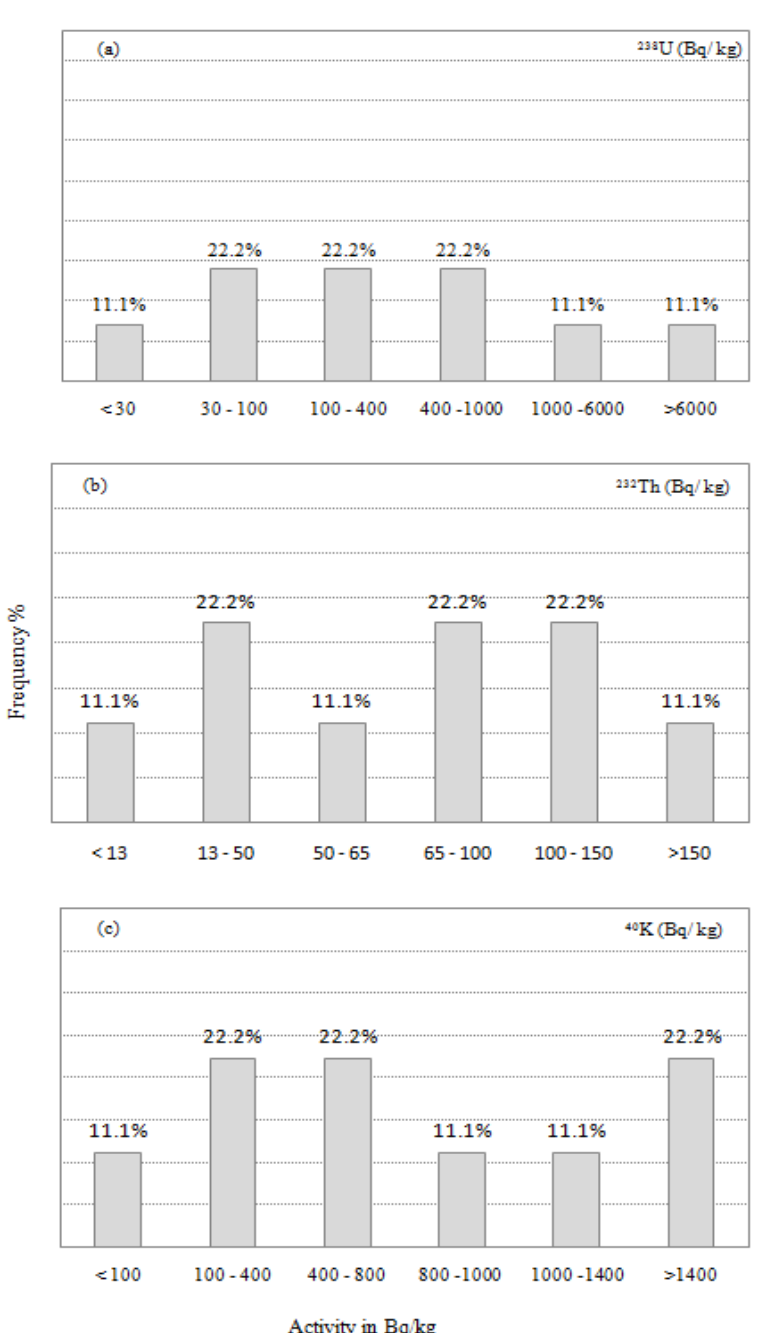
Figure 6. Frequency distribution of activity concentrations (Bq kg − 1 ) for the Sol Hamed lamprophyre dykes: ( a ) 238 U; ( b ) 232 Th; ( c ) 40 K.